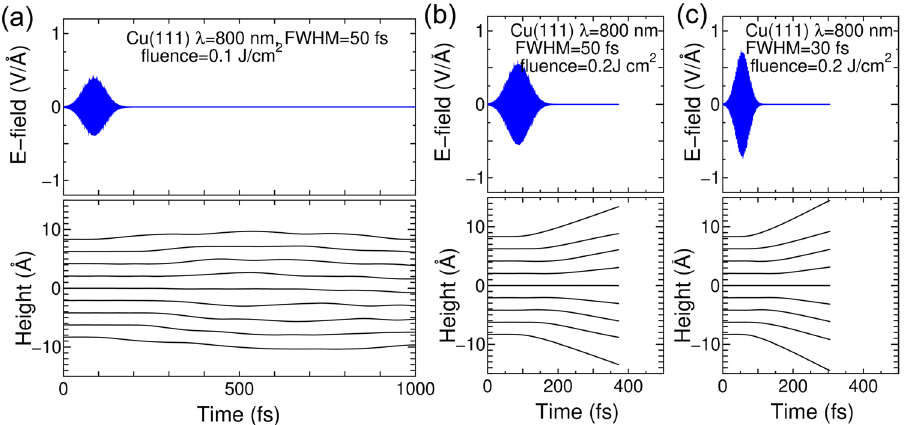
Figure 4. ( a ) TDDFT-MD simulation of a Cu slab upon a laser shot with wavelength of 800 nm, FWHM of 50 fs, and fluence of 0.1 J/cm 2 . The upper panel shows the time variation in the laser field polarized along the y